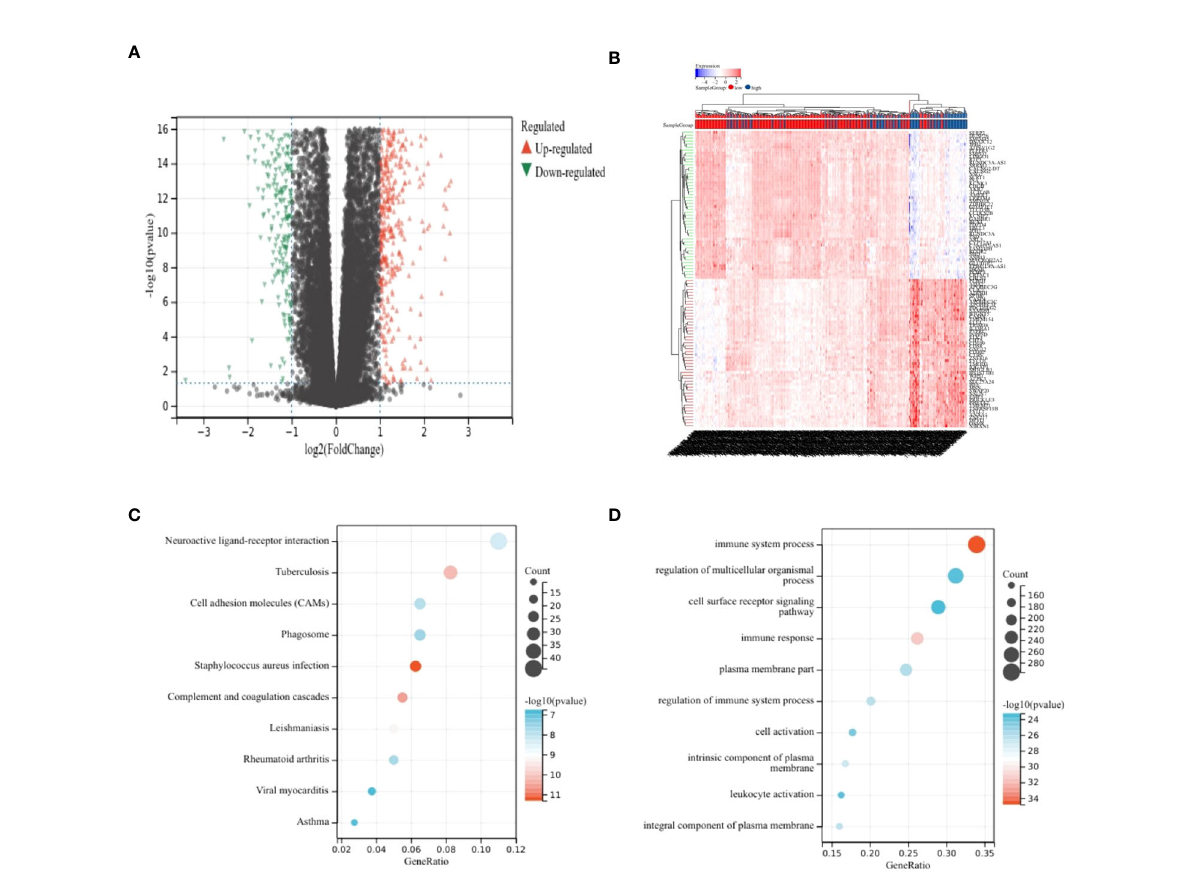
FIGURE 2 Analysis of differences. (A, B) Volcano plot showing DEGs in different risk score groups. (C) Bubble plot from KEGG analysis showing major enrichment of DEGs. (D) Bubble plot from GO analysis showing major enrichment of